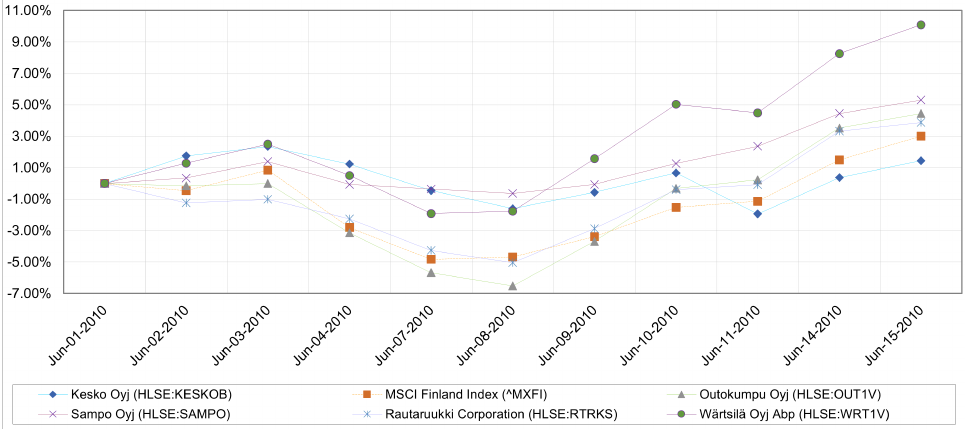
Figure 2. Stocks performance against the market